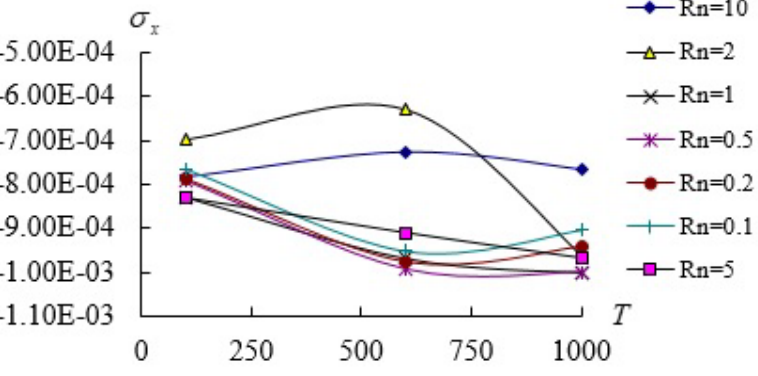
Figure 5. σ x (unit GPa) vs. T (unit K) for a / h ∗ = σ (unit GPa) vs. T (unit K) for 5/ * = ha . Figure 5. σ (unit GPa) vs. T (unit K) for 5/ * = ha . x Figure 5. x